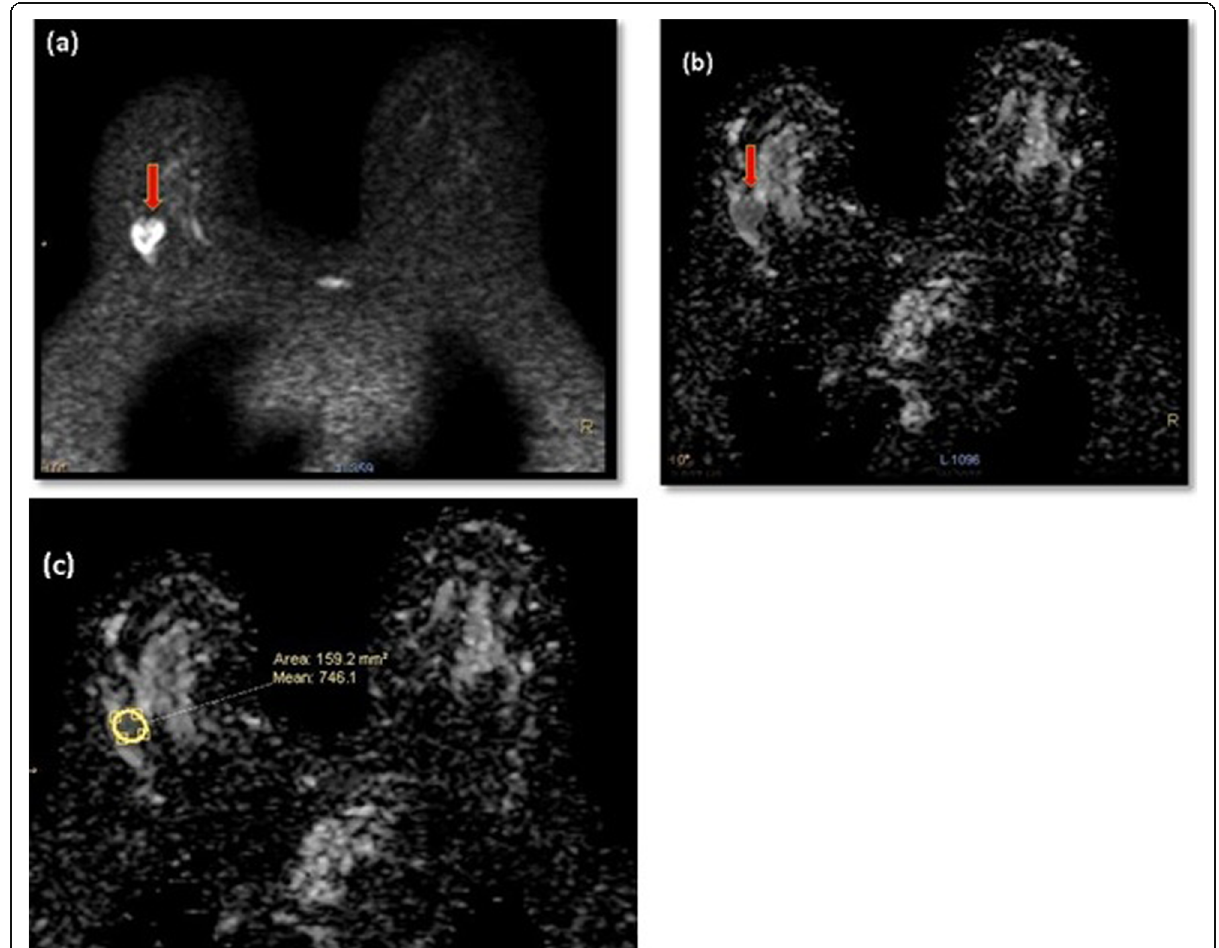
Fig. 3 DWIs analysis. a DWI at b 1500, b ADC map, c ADC value of 0.74 × 10 – 3 mm 2 /s. Right breast upper outer solid mass showed restricted diffusion of persistent bright SI on DWI and low SI on ADC map with an estimated ADC value of 0.74 × 10 – 3 mm 2 /s. Pathology and immunohistopathology revealed invasive duct carcinoma, grade III, positive for ER, PR and HER2